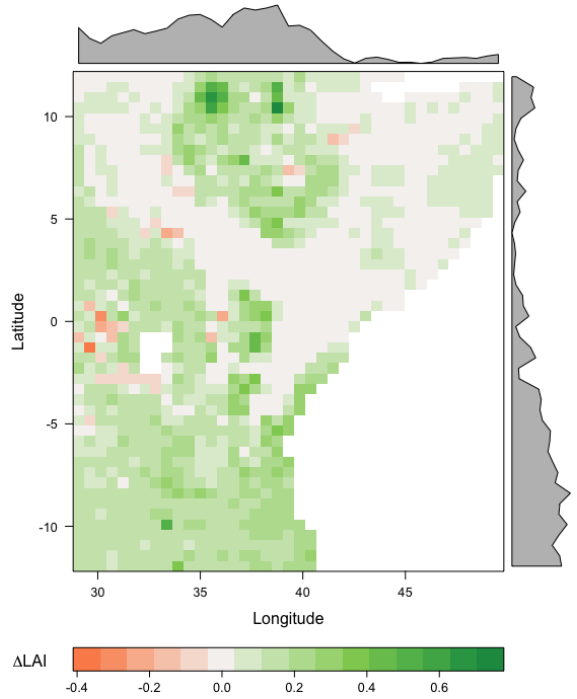
Figure A4. Simulated woody vegetation leaf area index (LAI) differences under future climate scenario RCP8.5 (without any manipulation to the ENSO signal) and present day (PD) ( (cid:49) LAI = RCP8.5 − PD).